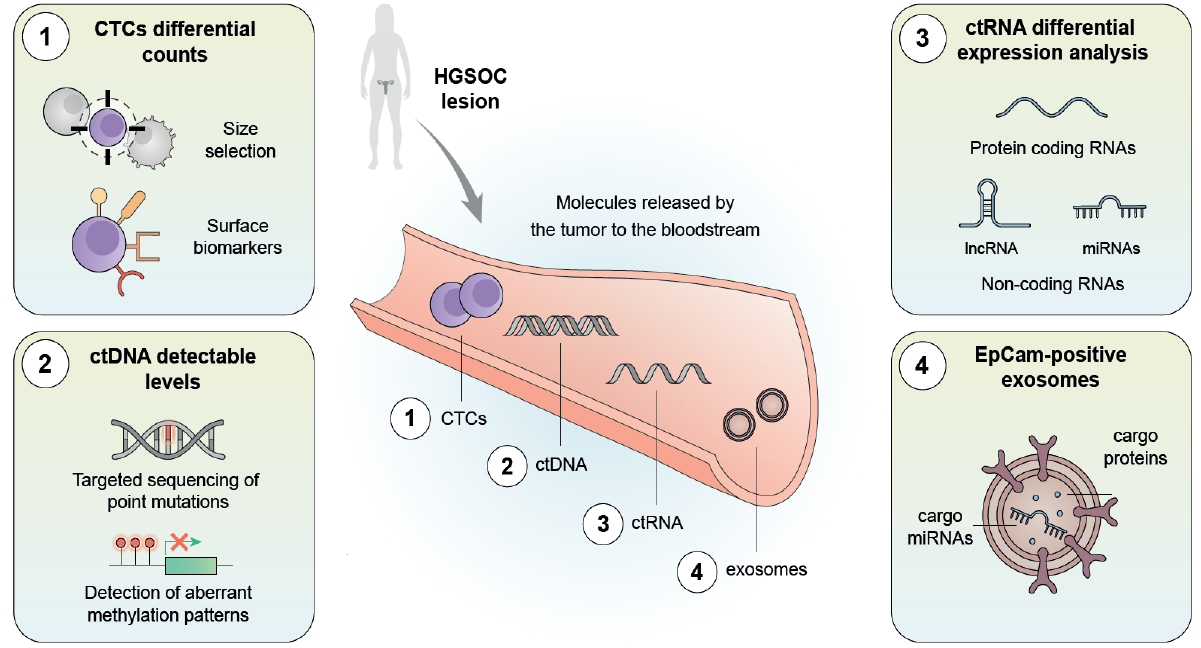
Figure 3. Liquid biopsy strategies for the early detection of HGSOC: Liquid biopsies rely on iso- lating CTCs, ctDNA, ctRNAs, or exosomes released by tumors that enter the bloodstream. Different analytical techniques support the identification of putative biomarkers for the early diagnosis of HGSOC.